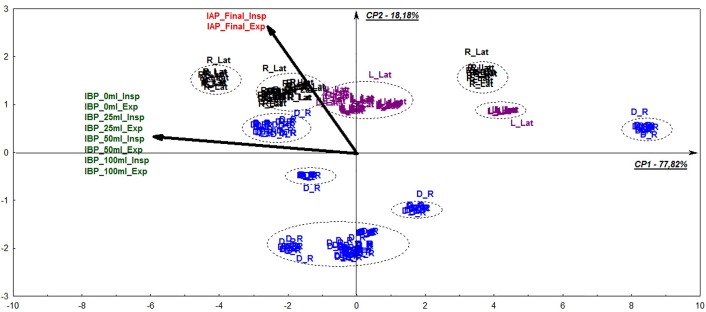
Exploratory multivariate analysis of multiple correspondence of 20 equine patients anesthetized in different body positions.Perceptual multiple correspondence (multivariate exploratory) analysis map of 20 horses that had IAP and IBP recorded in different body positions during elective surgical procedures. The present data express 96% of the data variability (Factor 1 + Factor 2). Patients remained in either dorsal recumbency (D_R) or right (R_Lat) or left (L_Lat) lateral recumbency. Intra-abdominal pressure was recorded at end-inspiration (IAP_Final_Insp) and end-expiration (IAP_Final_Exp). Intrabladder pressure was obtained simultaneously with IAP, with the bladder empty (IBP_0ml_Insp; IBP_0ml_Exp) and distended with 25 ml (IBP_25ml_Insp; IBP_25ml_Exp), 50 ml (IBP_50ml_Insp; IBP_50ml_Exp) and 100 ml (IBP_100ml_Insp; IBP_100ml_Exp) of 0.9% NaCl solution.